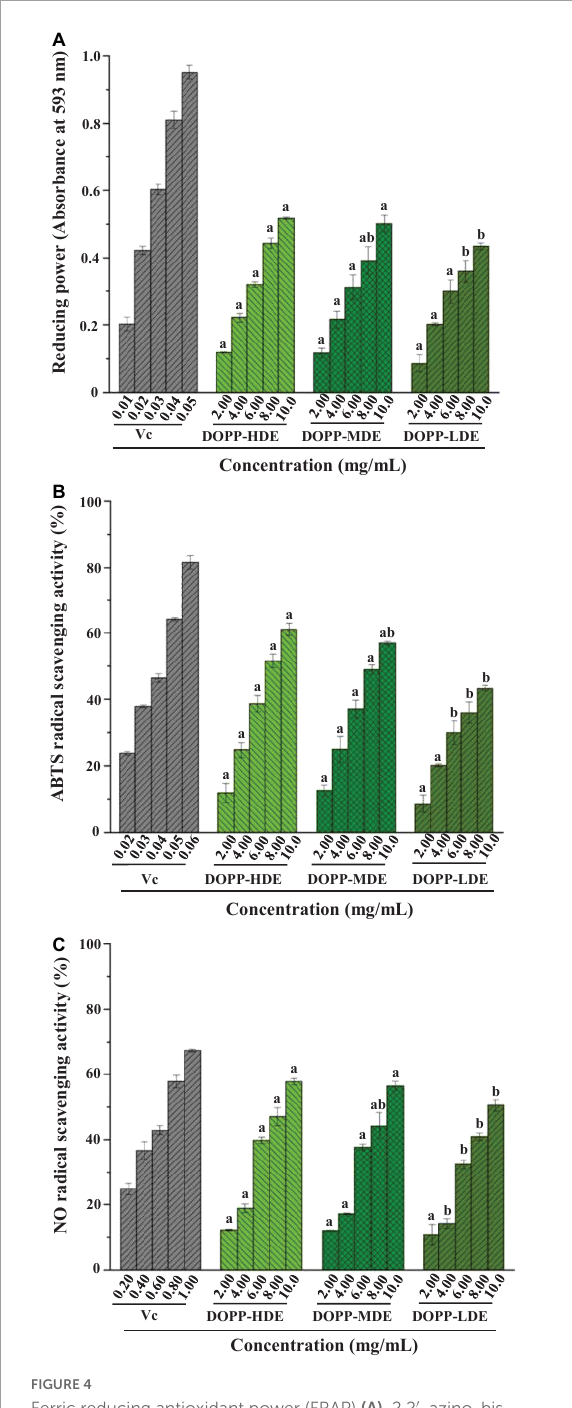
FIGURE4 Ferric reducing antioxidant power (FRAP) (A) , 2,2 (cid:48) -azino-bis (3-ethylbenzthiazoline-6-sulphonic acid) (ABTS) radical scavenging activity (B) , and nitric oxide (NO) radical scavenging activity (C) of okra pectic-polysaccharides (OPP) with various degrees of esterification. The sample codes were the same in Figure 1 ; the error bars are standard deviations; significant ( p < 0.05) differences among OPP with various degrees of esterification are shown by data bearing different letters (a-b); statistical significances were carried out by ANOVA and Ducan’s